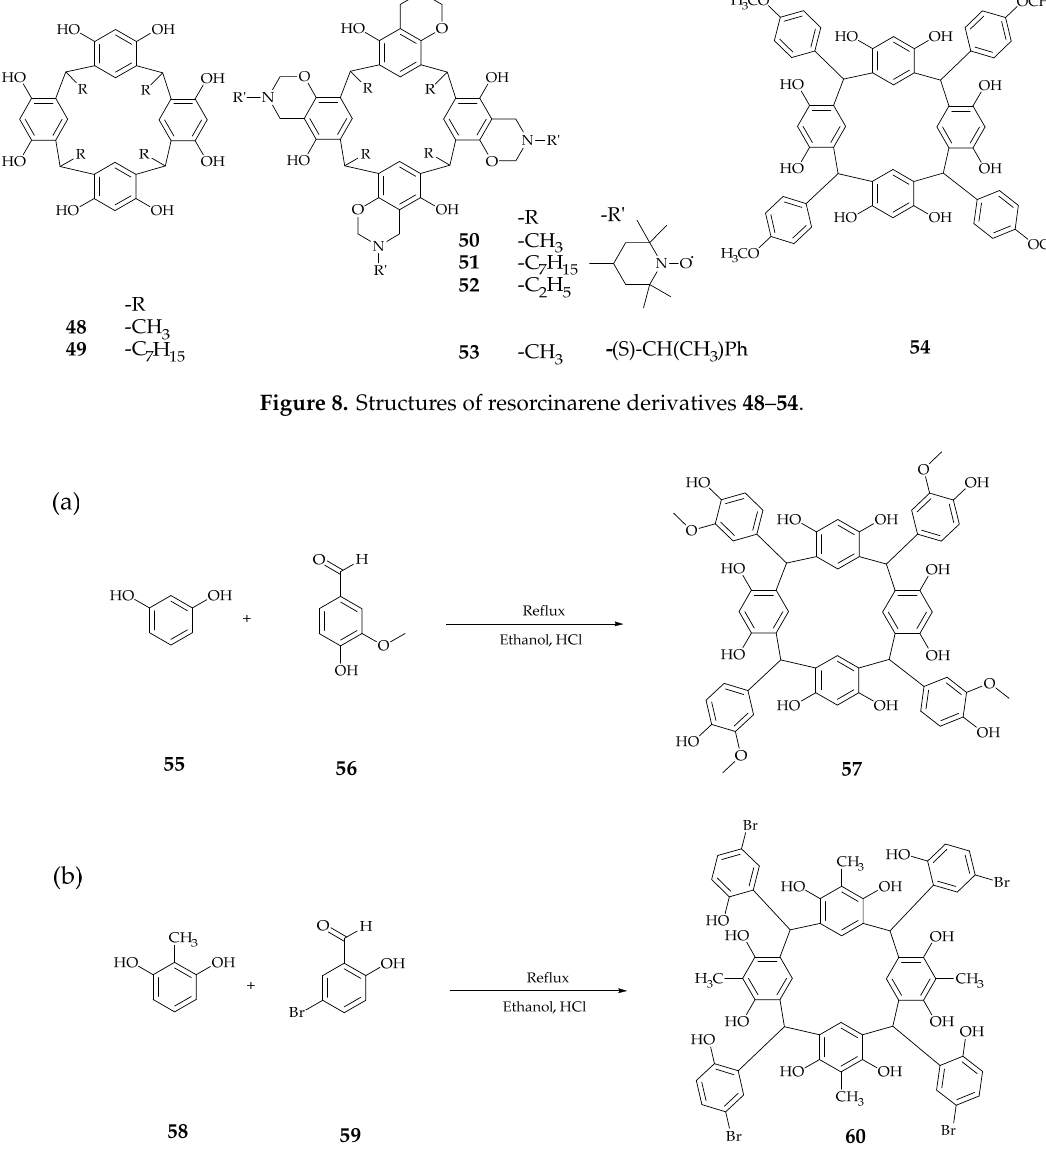
Scheme 5. General scheme for the synthesis of resorcinarene derivative ( a ) compound 57 containing vanillin arms; ( b ) compound 60 containing 5-bromo-2-hydroxybenzene